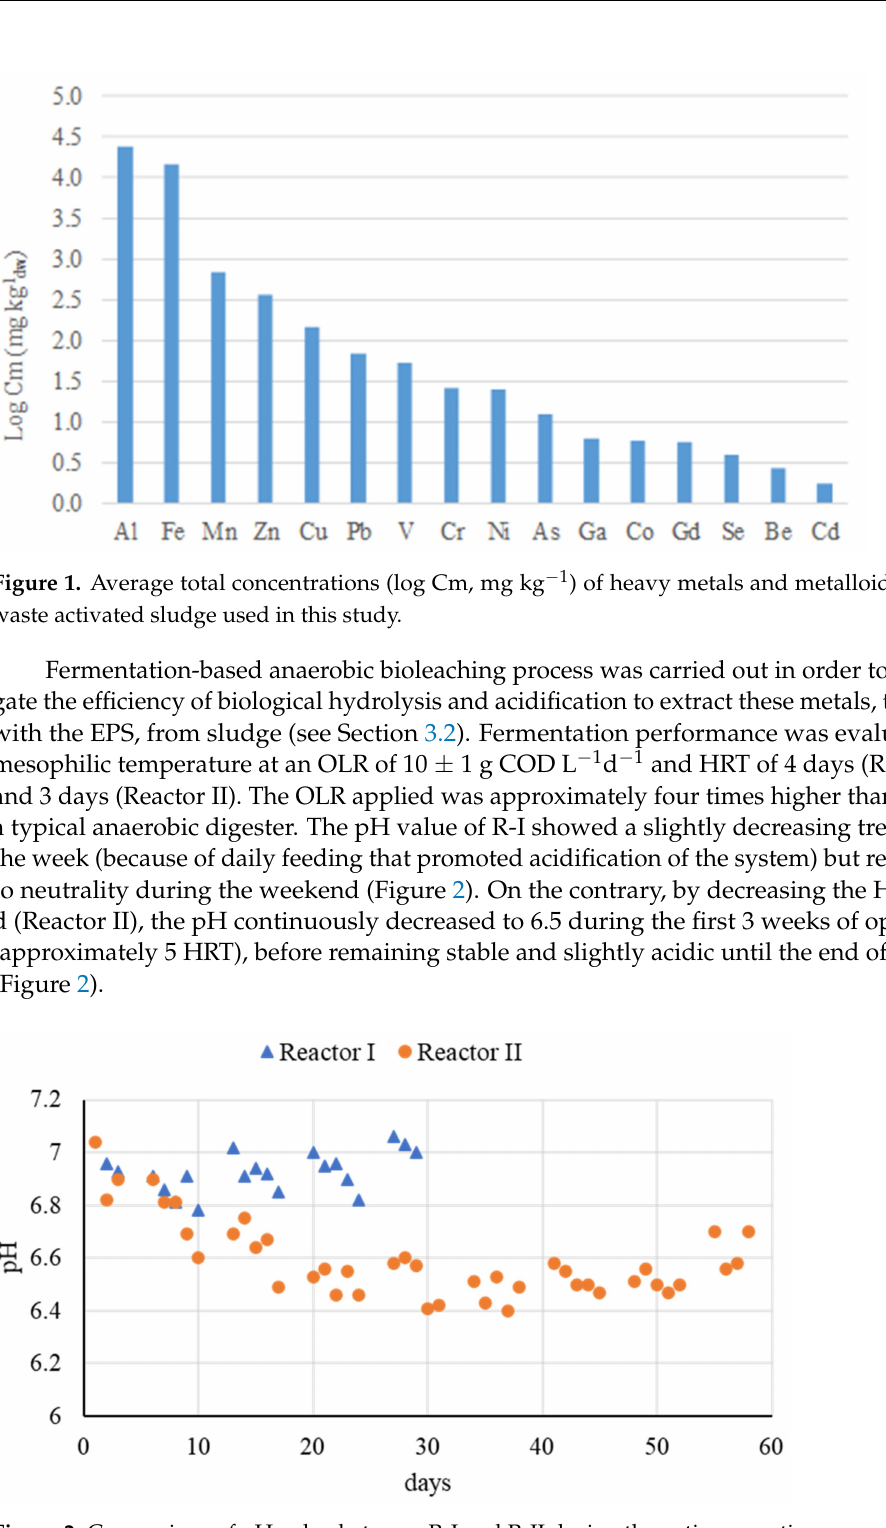
Figure 2. Comparison of pH value between R-I and R-II during the entire